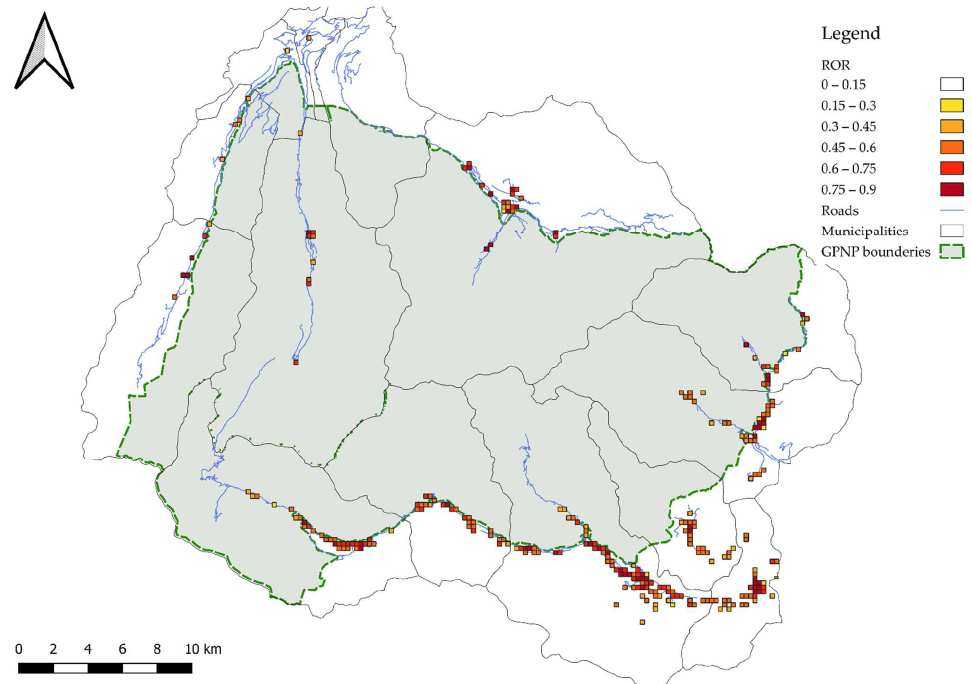
Figure 4. The map shows the output of the MaxEnt model ROR, or the relative probability that each has a suitable predicted condition for Cacyreus marshalli . The borders of the municipalities included in the analysis are shown in green, while the streets are in grey. The grey polygon marks the Park territory, in which only one sampled valley is included entirely. The colour scale, in the top right corner, indicates the ROR values.